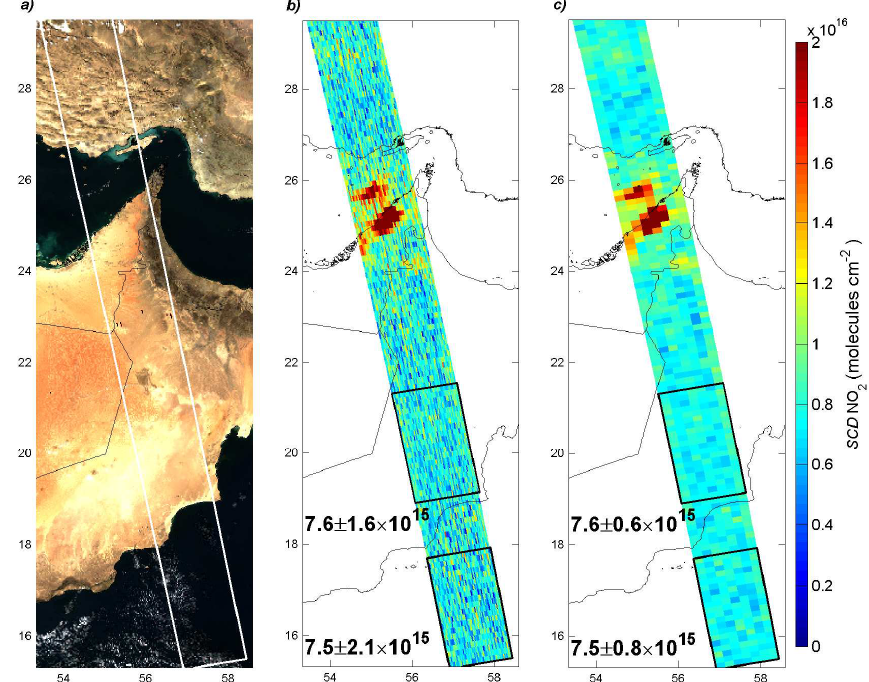
Figure 2. a ) MODIS RGB image, b ) super-zoom slant column NO 2 , and c ) operational-scale slant column NO 2 over the eastern Arabian Peninsula on 21 November 2004. The mean and 1 σ -uncertainty of slant column NO 2 retrieved from super-zoom and operational-scale observations over the remote ocean and desert are reported.